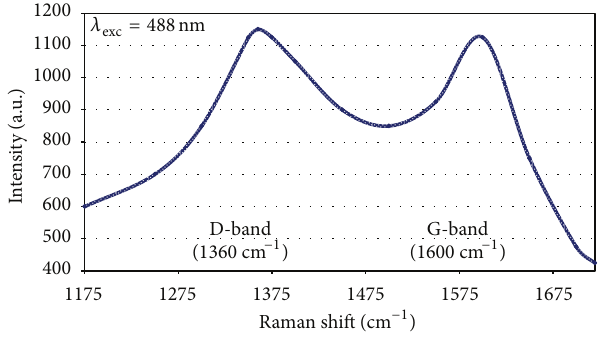
Figure 2: Raman spectrum of typical nanographite